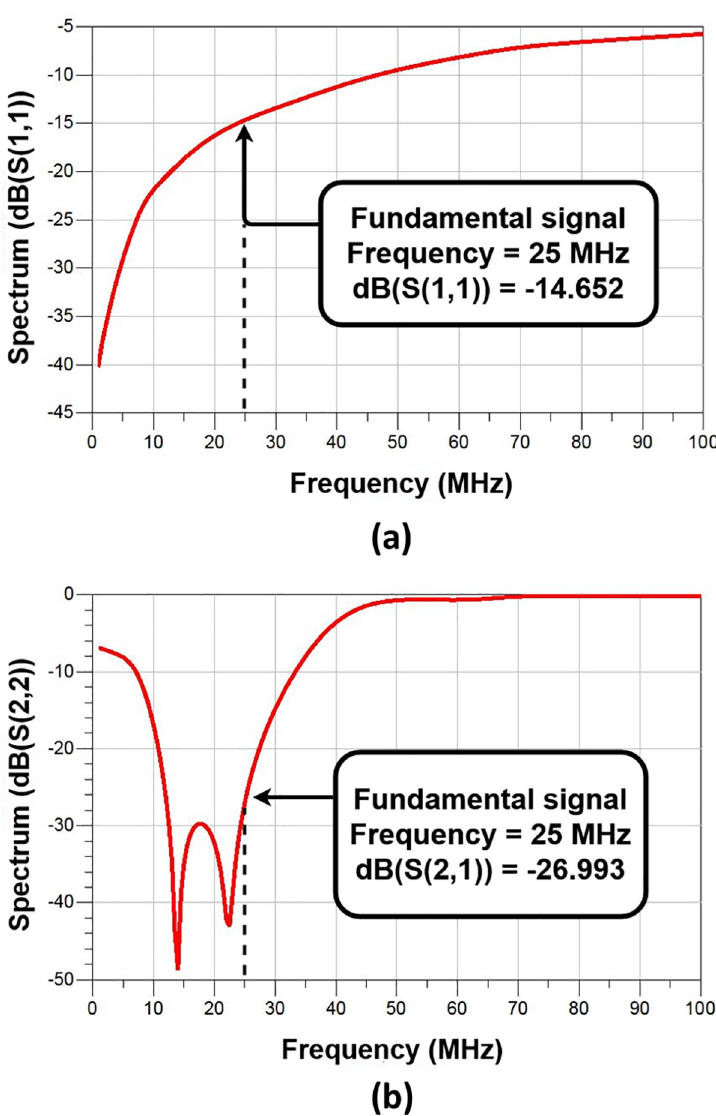
Fig 8. Simulation data of high-efficiency and high-voltage class F amplifier. S parameter used for impedance matching (a) S11, (b) S22.